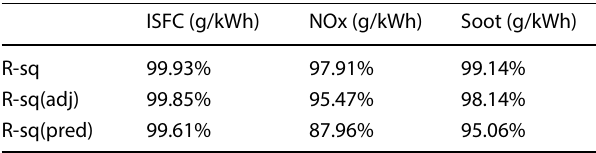
Table 4 Model evaluation of RSM